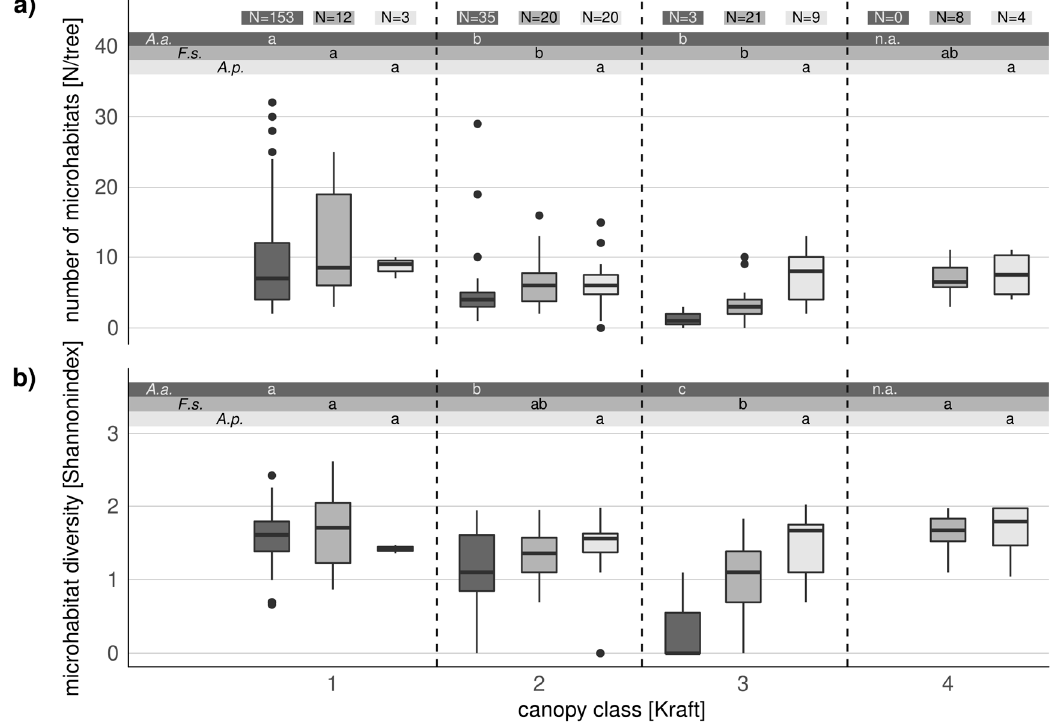
Figure 3. Relationship between tree canopy class and microhabitat frequency ( a ) and diversity ( b ) in habitat trees of the tree species Abies alba ( A. a. ), Acer pseudoplatanus ( A. p. ), and Fagus sylvatica ( F. s. ). Different letters indicate significant differences between canopy classes of each tree species. The black bar indicates the median, the box shows the interquartile range, and the whiskers the 1.5-interquartile range.